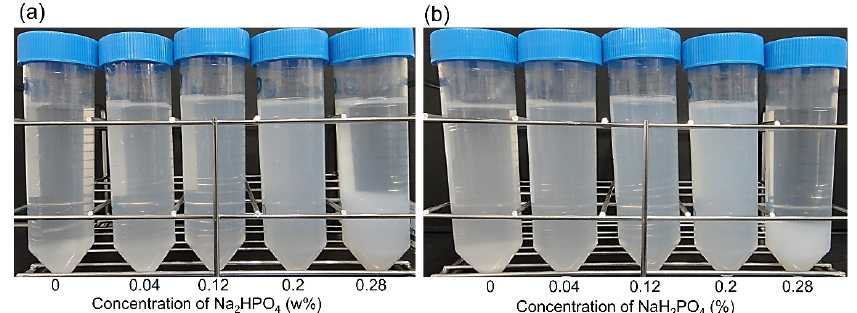
Figure 2. Formation of BiSCaO ‐ 6 dispersions and flocculants by the addition of Na 2 HPO 4 or NaH 2 PO 4. 0.04 wt%, 0.12 wt%, 0.2 wt%, and 0.28 wt% of Na 2 HPO 4 ( a ) and NaH 2 PO 4 ( b ) were added to 0.2 wt% BisCaO ‐ 6 suspension and rotary mixed.